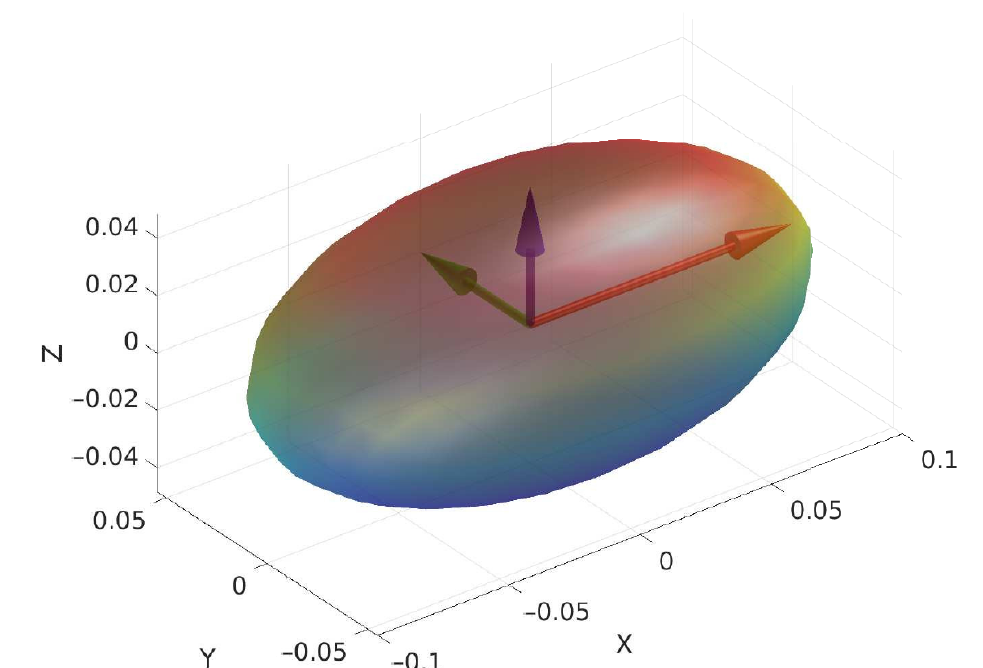
Figure 5. The inertia tensor can be seen as an ellipsoid. Its principal axes are in the direction of the eigenvectors of the tensor and their lengths depend on the